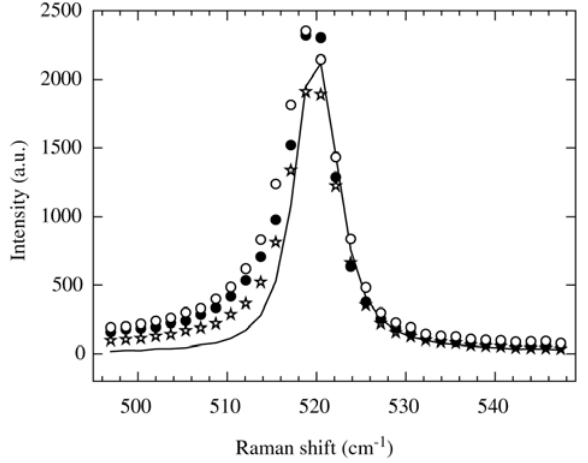
Figure 1. Raman spectra measured in the vicinity of the Si peak for PS layers samples with 1(stars), 5 (open circles), and 8 (closed circles) min of etching time. The solid line represents the spec- trum of monocrystalline